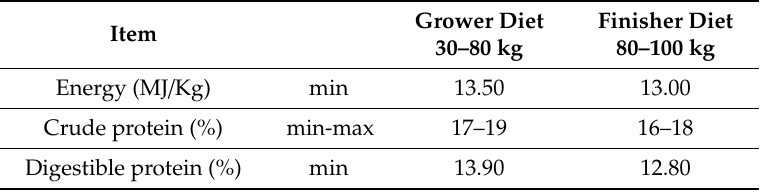
Table 1. Calculated content of energy and protein in the pig